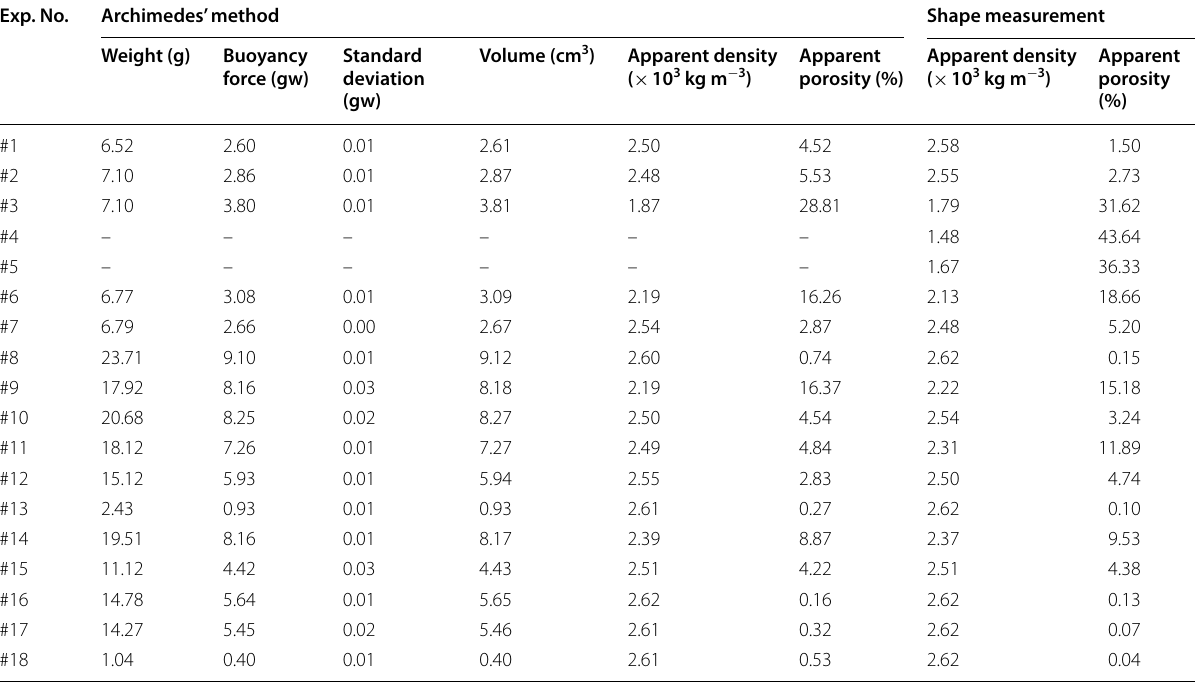
Table 3 Evaluation of densification using Archimedes’ principle Exp.